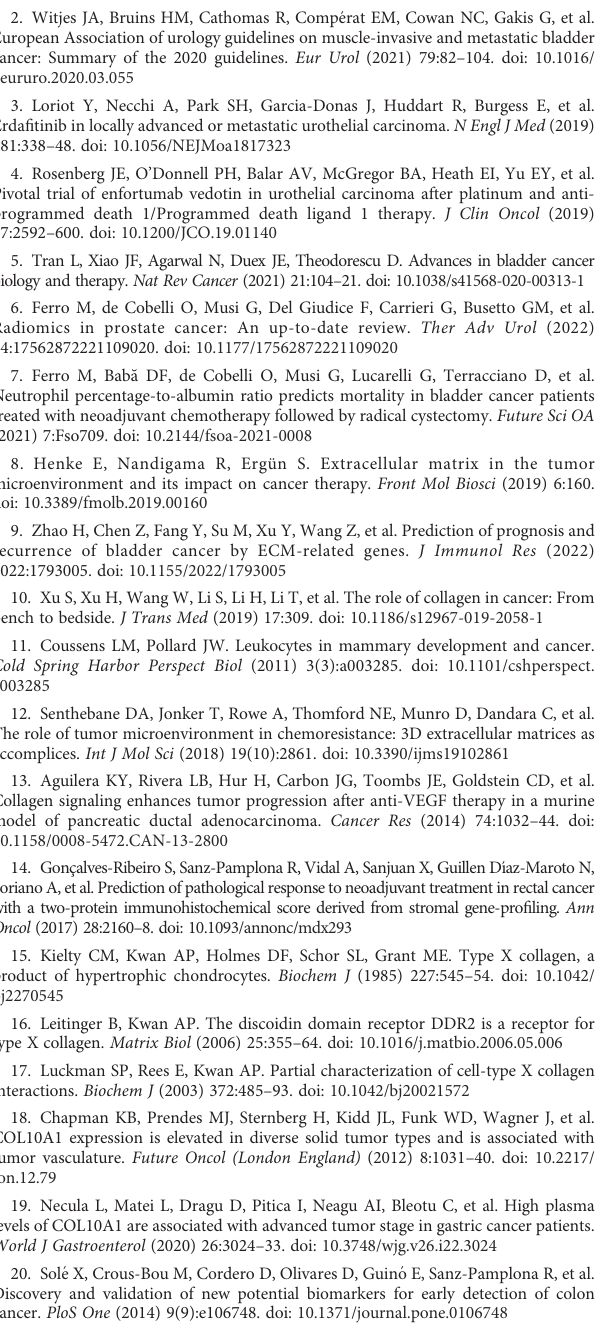
SUPPLEMENTARY FIGURE 3 The summary information of mutation data in the high (A) and low (B) COL10A1 groups in the TCGA-BLCA